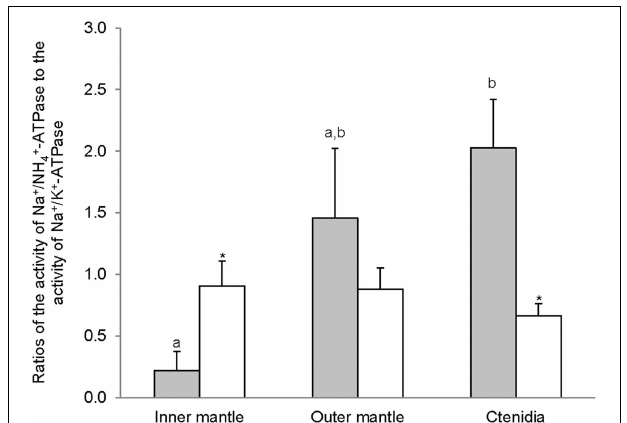
FIGURE 3 | The effectiveness of NH + 4 substituting for K + to activate Na + /K + -ATPase (NKA), expressed as the activity ratio of Na + /NH + 4 -activated-NKA to Na + /K + -activated-NKA, from the inner mantle, the outer mantle, and ctenidia of Tridacna squamosa exposed to 12h of darkness (control; closed bar) or 12h of light (open bar). Values represent means + S.E.M. ( N = 4 ). Means not sharing the same letter (a, b) are significantly different from each other ( P < 0 . 05 ). ∗ Significantly different from the control value ( P < 0 . 05